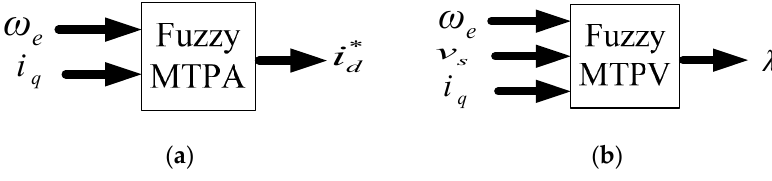
Electronics 2018 , 7 , x FOR PEER REVIEW Figure 4. Fuzzy control based MTPA ( a ), and MTPV ( b ). Figure 4. Fuzzy control based MTPA ( a ), and MTPV ( b ).